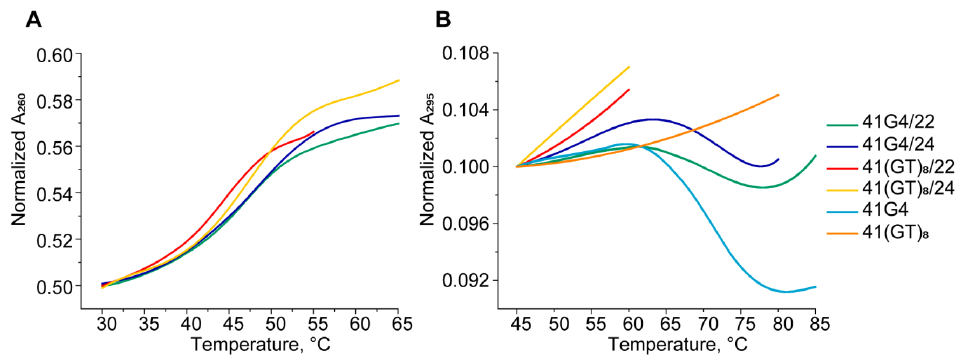
Figure 5. Thermal melting curves of single- and double-stranded DNA models in buffer A at ~3 µM oligonucleotide strand concentration. Melting curves for UV absorbance ( A ) at 260 nm and ( B ) at 295 nm. Table 1. T m values determined from di ff erential UV melting curves for a G4 (at 295 nm) and DNA duplex (at 260 nm) domains in bu ff er